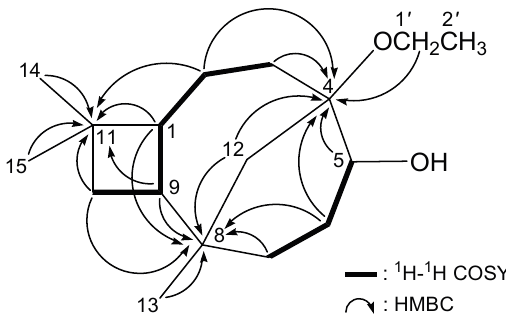
Figure 3. 1 H– 1 H COSY and selective HMBC correlations (protons → quaternary carbons) of 2 .